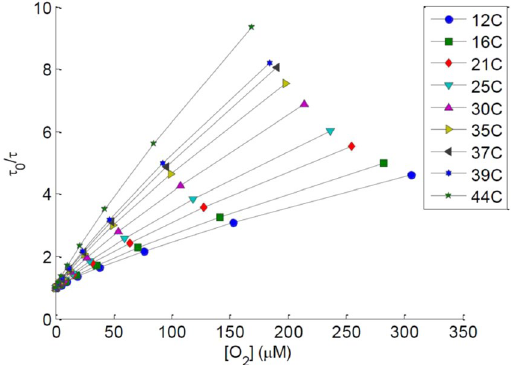
Figure 2. In vitro calibration of the biosensors demonstrating phosphorescent lifetime versus oxygen concentration at nine different temperatures.